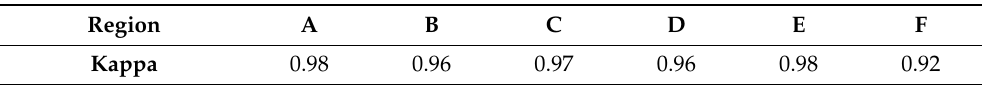
Figure 13. The t-sen diagram of the suggested method for single-channel region (E). Table 2. The kappa coefficient of the suggested method for all